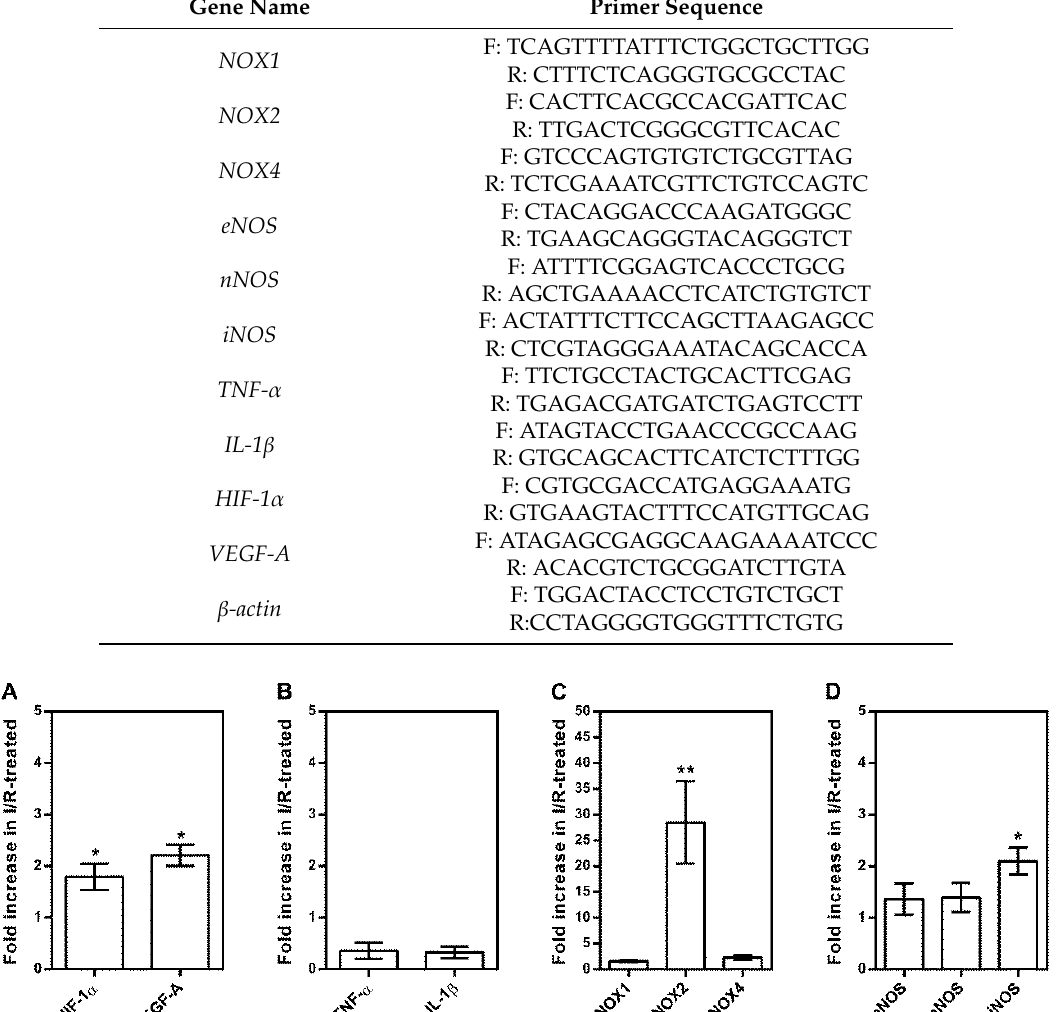
Table 2. Primer sequences for mRNA expression studies.